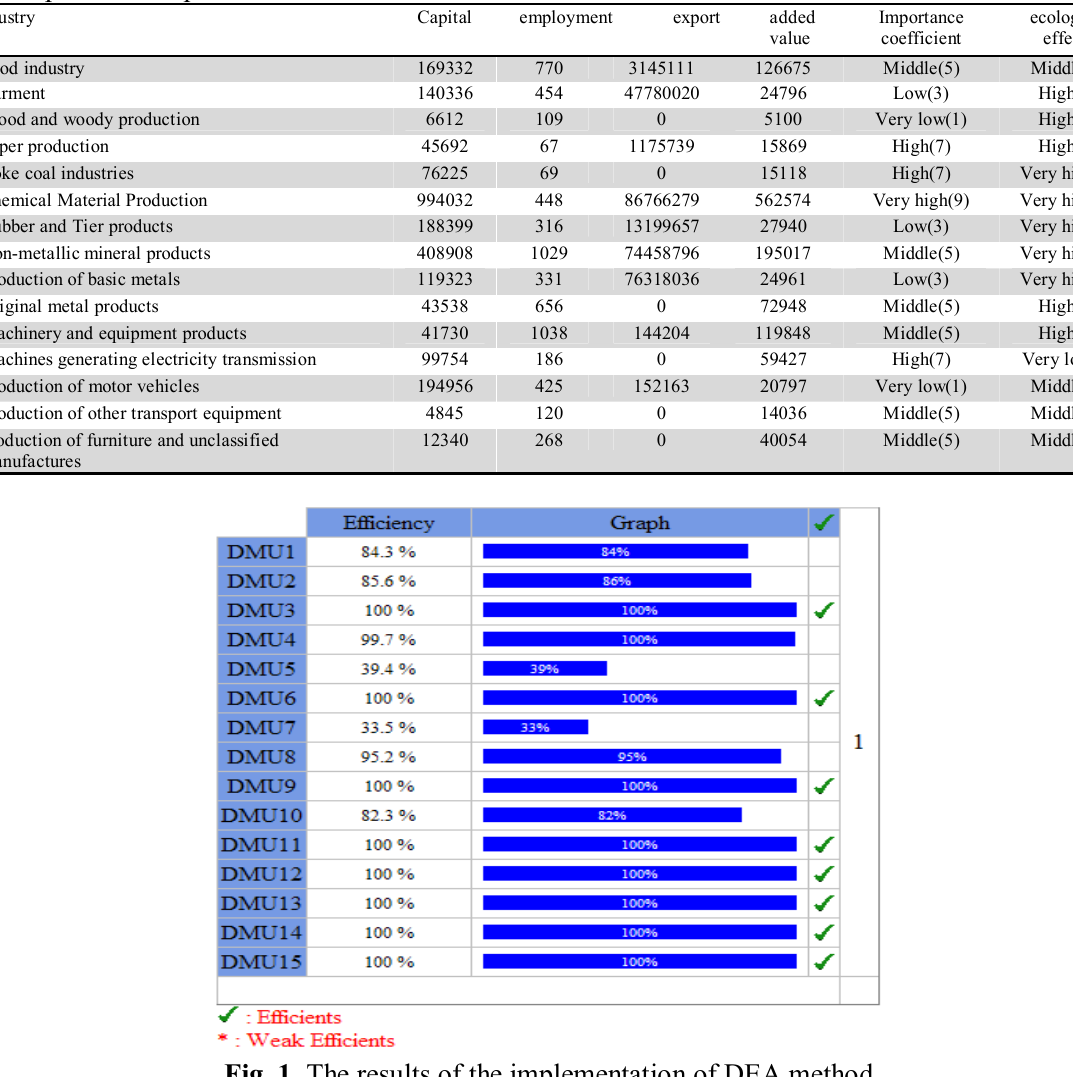
The inputs and outputs used for DEA model